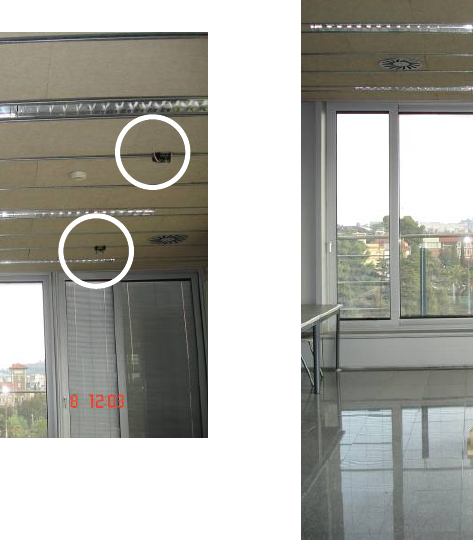
Figure 28 . Error correction environment.